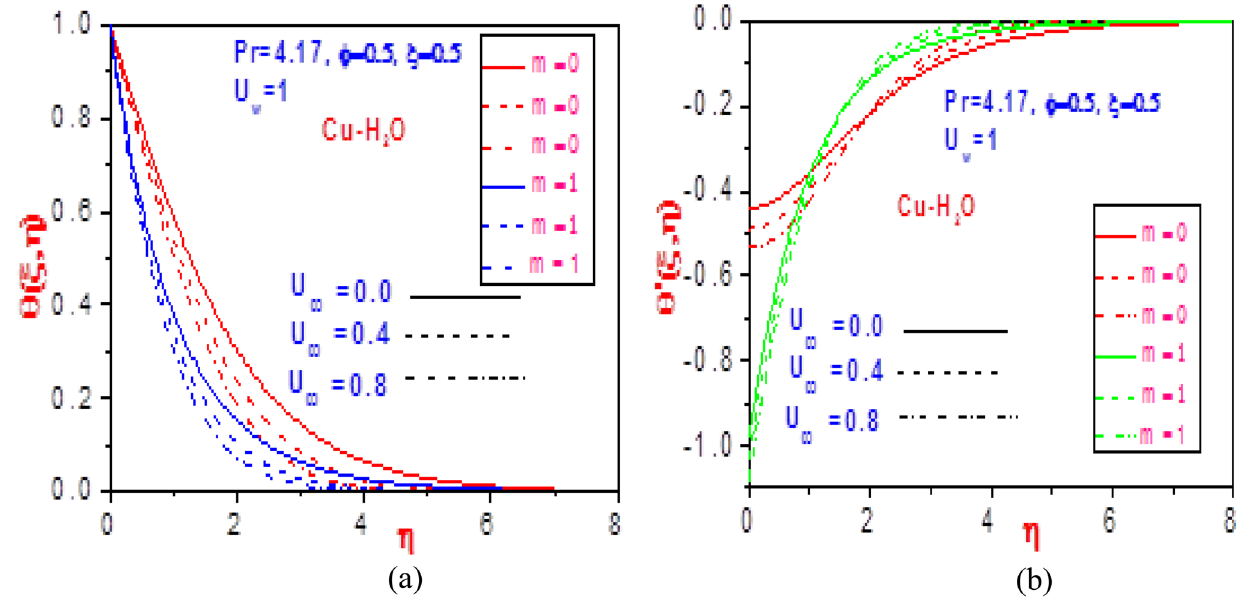
Figure 13. Profiles of ( a ) temperature θ(ξ , η) and ( b ) missing temperature slope θ ′ (ξ , η) with different values of U ∞ and m for Cu-H